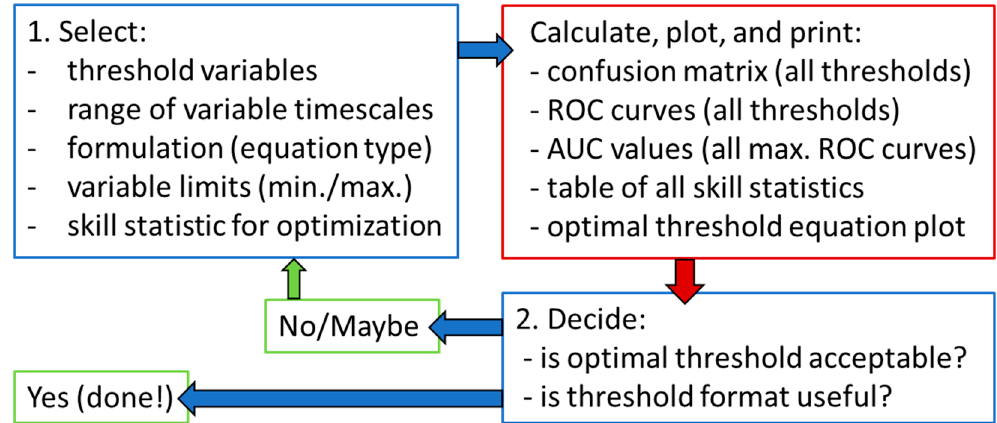
Figure 1. Schematic flow-chart of iterative, semi-automated process to identify appropriate threshold space, defined by input variables and timescales and optimize preferred threshold equation using receiver operating characteristics (ROC) analysis. Blue boxes and arrows indicate user input, red boxes and arrows indicate automated calculations, green boxes and arrows indicate user decisions.